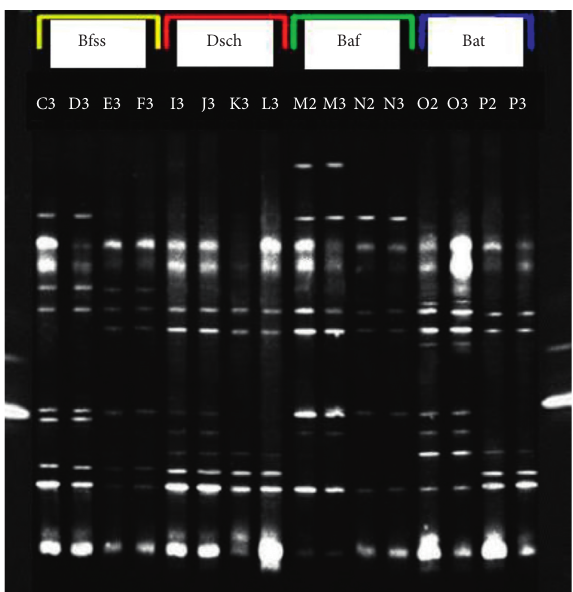
Figure 3: DGGE profiles of DNA extracted from moulds of coffee samples collected in four Cameroonian cities: Bafoussam, Dschang, Bafia, and Batouri. Bfss: Bafoussam; Dsch: Dschang; Baf: Bafia; Bat: